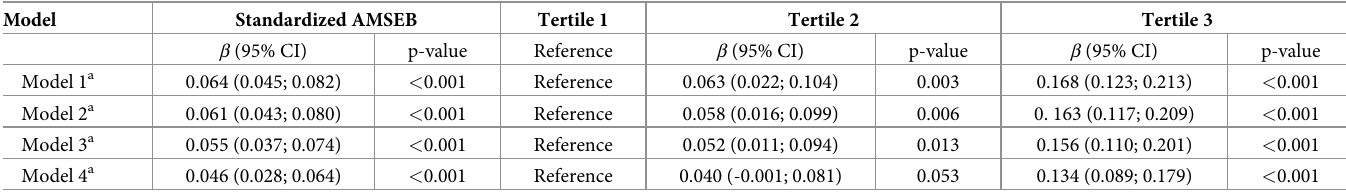
Table 2. Standardized regression estimates for the association between baseline adherence to moral standards and ethical behaviors and purpose in life over a four- year follow-up period in middle-aged and older adulthood. Health and Retirement Study, US, 2012/2014–2016/2018, n = 8,497 b